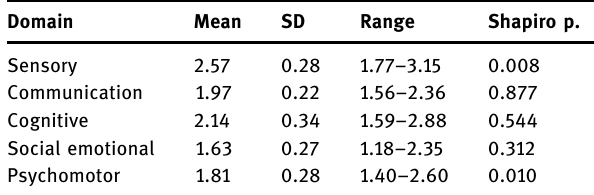
Table 5: Initial scores of domain scales